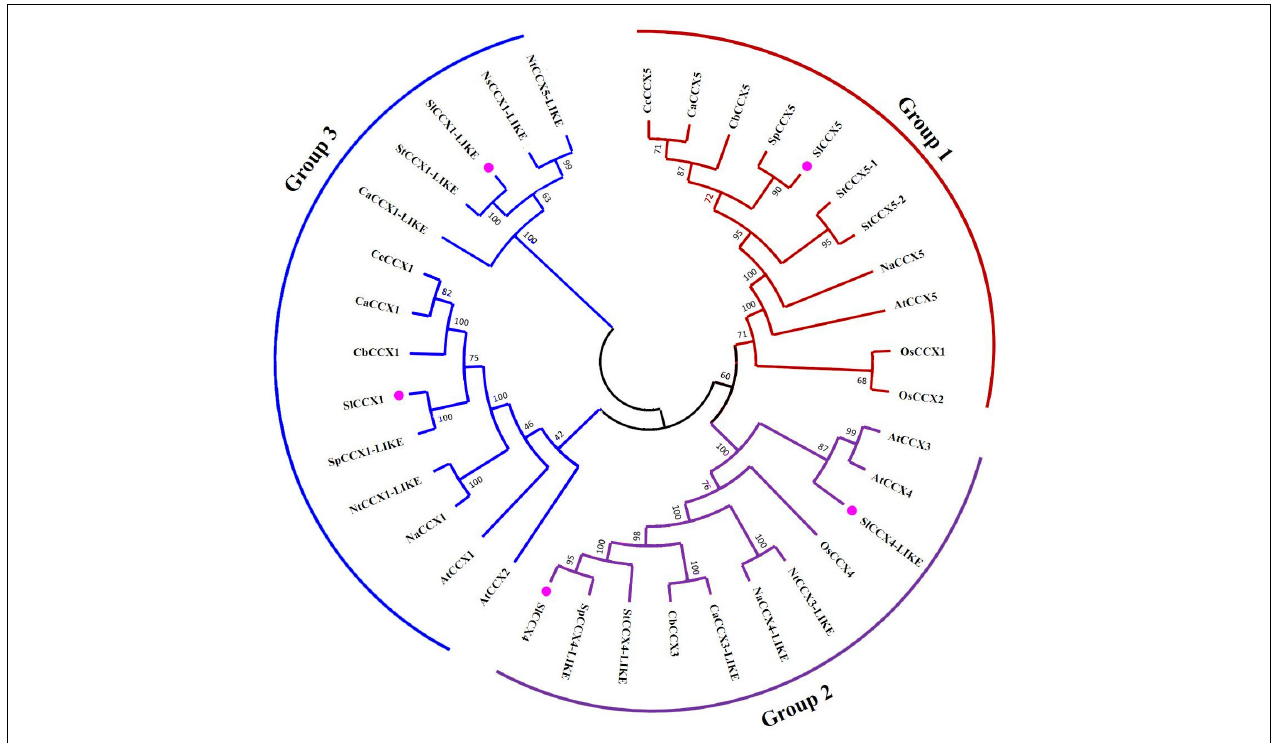
FIGURE 2 | Phylogenetic analysis in Solanaceae CCXs. Multiple sequence alignment of CCX proteins was done using DNAMAN, and phylogenetic tree was constructed using MEGA7.0 by the neighbor-joining method with the pairwise deletion option with Poisson correction. The number at each node represents the bootstrap value from 1,000 replicates. At , Arabidopsis thaliana ; Sp , Solanaceae pennellii ; St , Solanaceae tuberosum ; Na , Nicotiana attenuata ; Nt , Nicotiana tabacum ; Ca , Capsicum annuum ; Cb , Capsicum baccatum ; Cc , Capsicum chinense ; symbol indicates tomato SlCCX proteins.